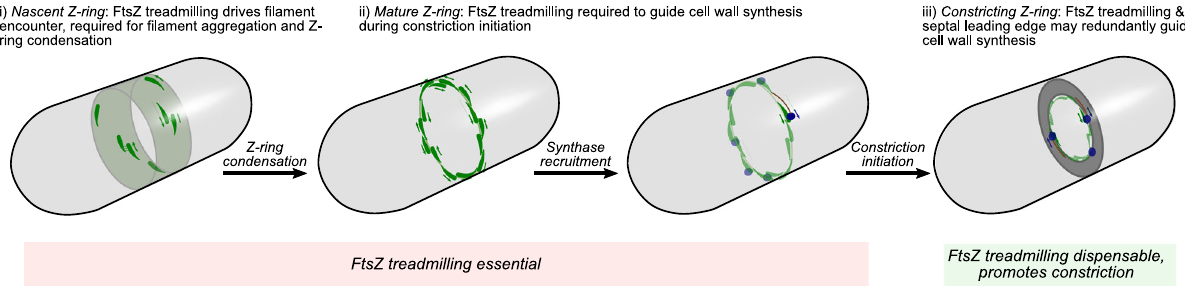
Fig. 5 Model for function of FtsZ treadmilling in Z-ring assembly and septal constriction. Schematics depicting stages of division along with key events and roles of FtsZ